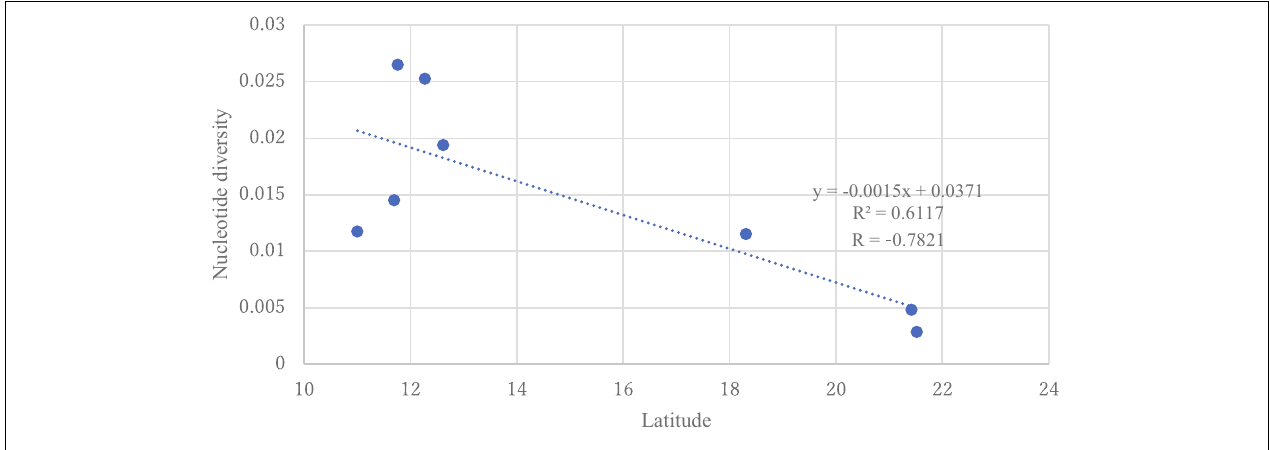
FIGURE 6 | Linear regression model for the latitude and nucleotide diversity of Hemileia vastatrix populations from Vietnam and Thailand. The dotted line represents the regression line with equation y = − 0.0015x +